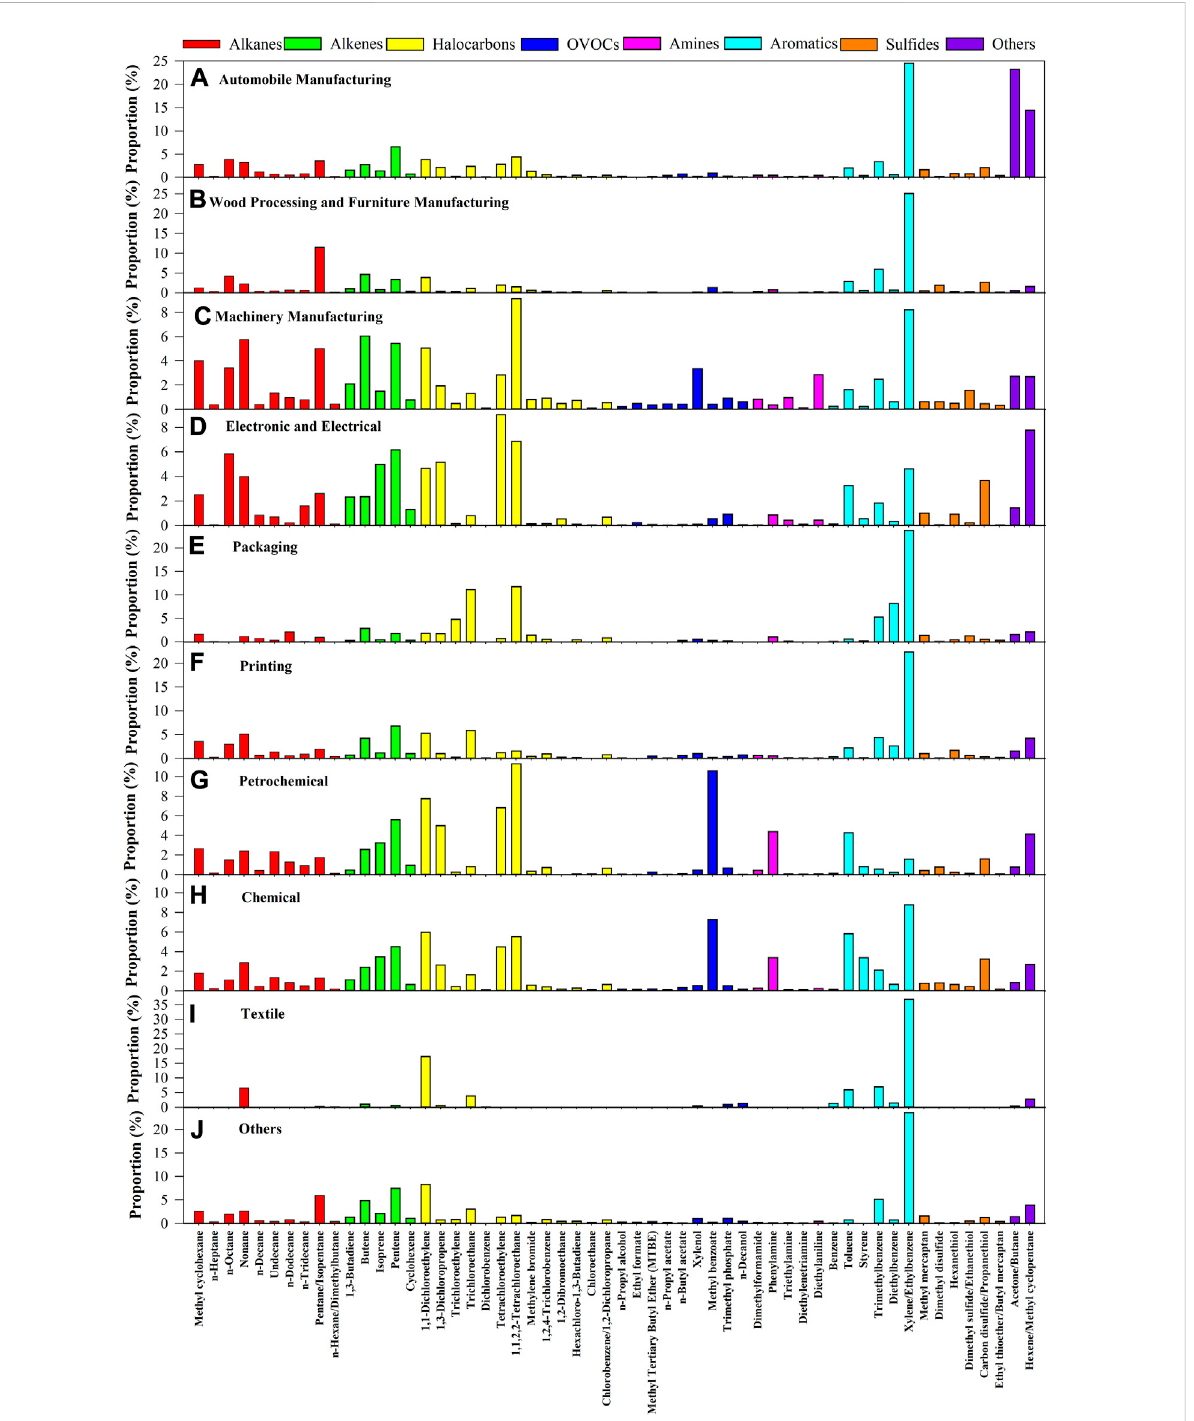
FIGURE 2 Localsourcepro fi leswiththeproportionof65VOCsspeciesinvariousindustriesofJilinProvince.Duetolargedifferencesintheconcentration of pollutants in various industries, the ordinate scale is not